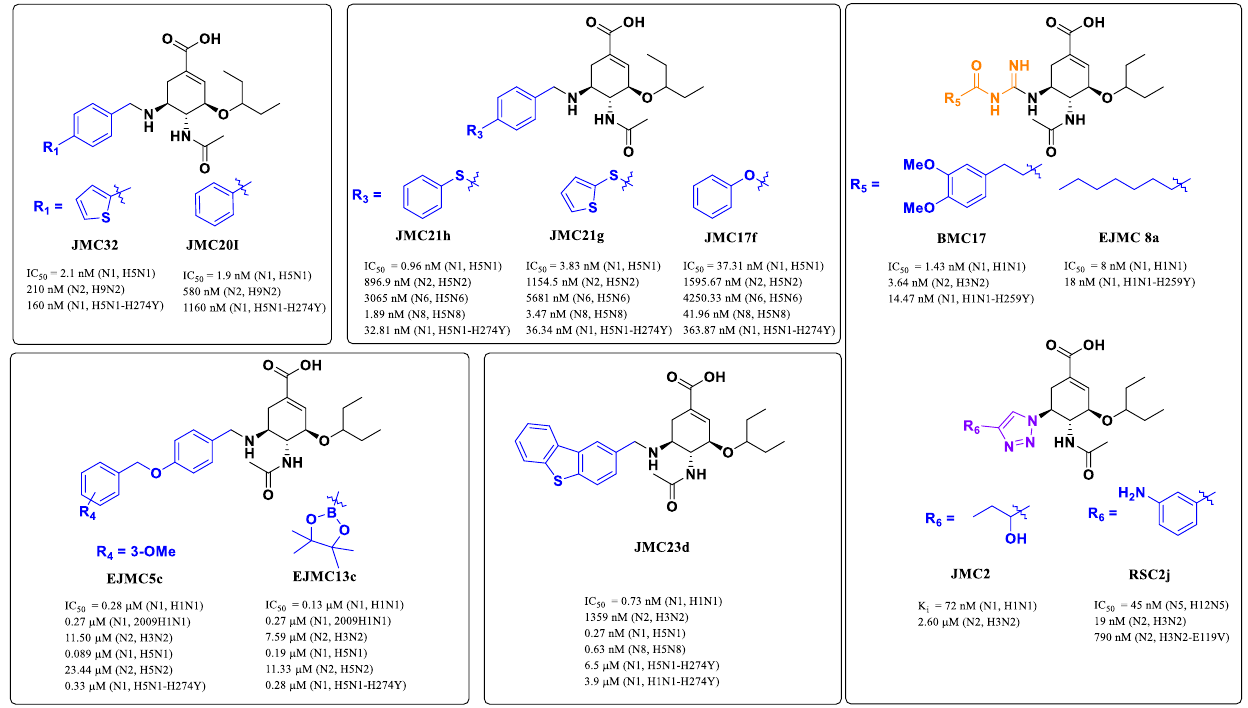
Figure 3. Structures of previously reported group-1-specific influenza NA inhibitors ( JMC32 , JMC20I , JMC21h , JMC21g , JMC17f , EJMC5c , EJMC13c and JMC23d ) and non-selective NA inhib- itors ( BMC17 , EJMC8a , JMC8a , RSC2j ).